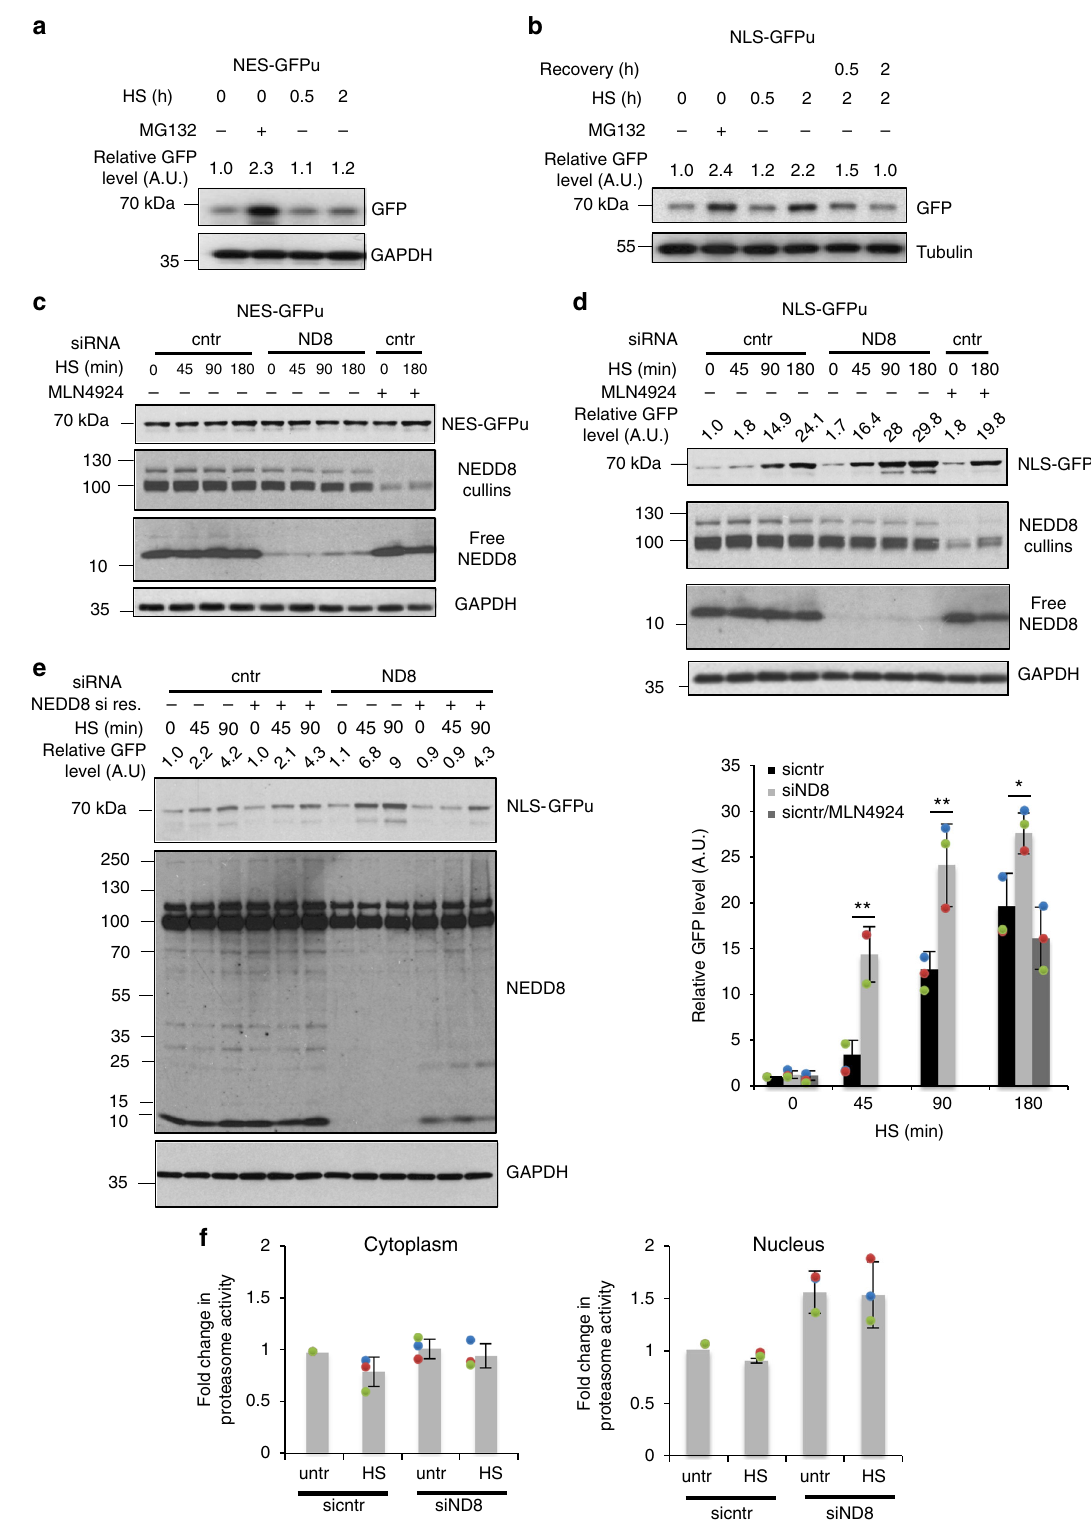
Figure 6), raising the possibility that NEDD8 can compromise substrate ubiquitination, the natural targeting signal to the proteasome. Knockdown of NEDD8 increased RPL7 ubiquitina- tion consistent with the idea that NEDD8 conjugation compromises substrate ubiquitination (Fig. 8a). Similar results were obtained upon NUB1 overexpression, which